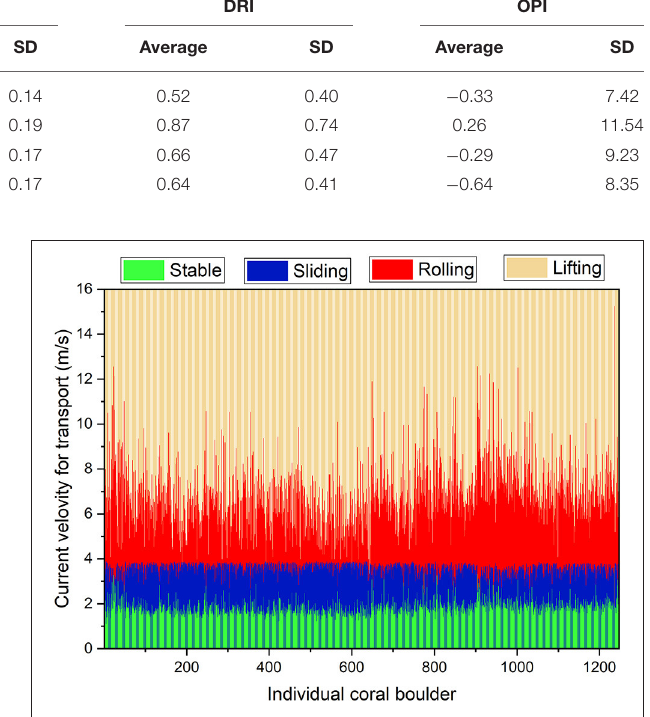
FIGURE 6 | Current velocities for initiation of boulders transport by different transport